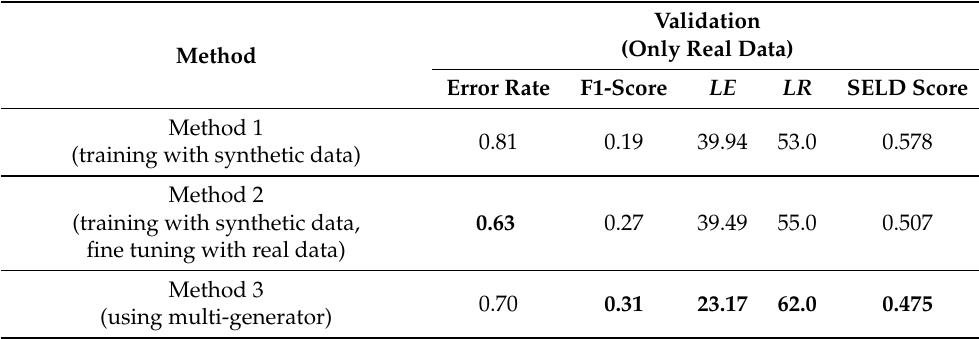
Table 1. Comparison of the trained model performances depending on the training methods. The values that have the best performance are